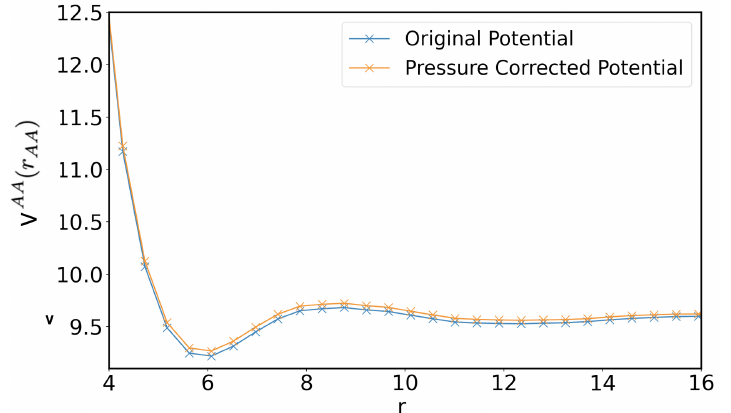
Figure 7. Comparison of the original coarse-grained potential in Kcal/mol obtained with the IBI method and the pressure corrected one for the inter-particle term AA as a function of their mutual distance in